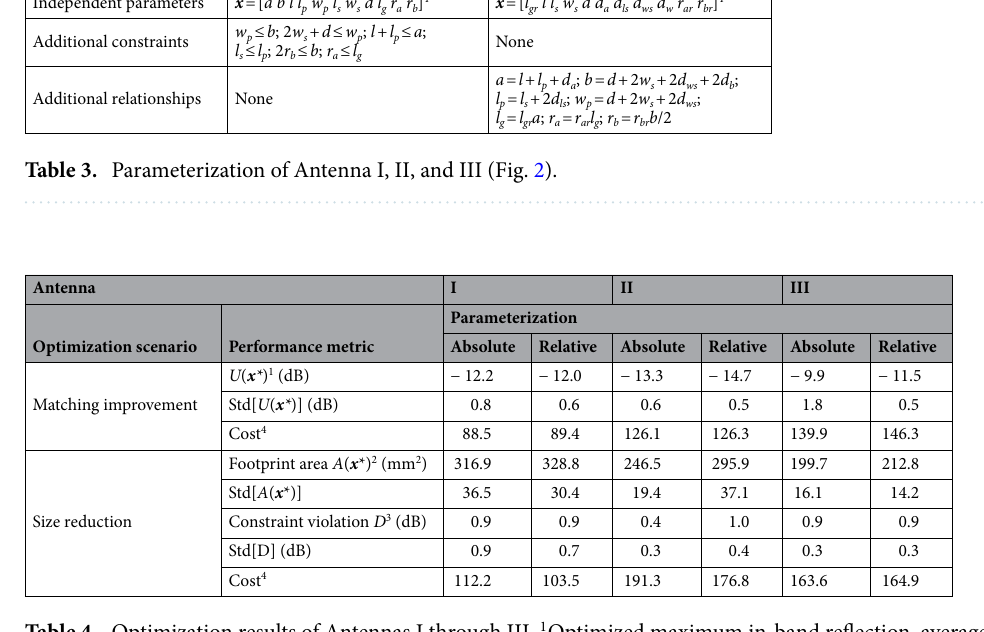
Table 4. Optimization results of Antennas I through III. 1 Optimized maximum in-band reflection, averaged over ten algorithm runs. 2 Optimized antenna footprint averaged over ten algorithm runs. 3 Constraint violation, defined as D = {3.1 GHz ≤ f ≤ 10.6 GHz : max| S 11 ( f )|} + 10, averaged over ten algorithm runs. 4 Number of EM simulations averaged over ten algorithm